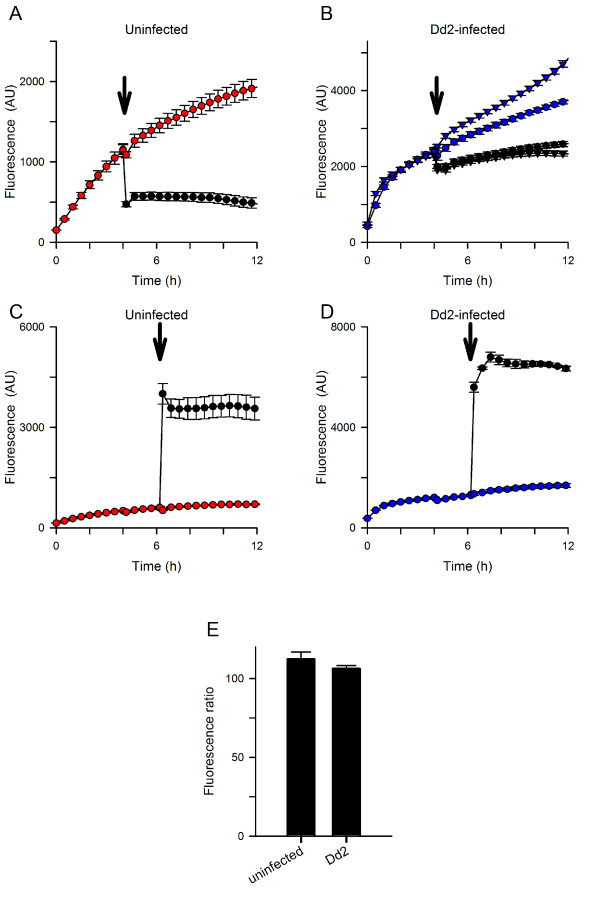
Effects of EGTA and SDS. (A, B) Addition of EGTA to chelate extracellular Ca++ 4 hours after initiating uptake (arrow in each panel; final [EGTA], 3.33 mM); the free Ca++ was buffered at 1.0 mM prior to EGTA addition. Panel A shows uninfected cells in the absence of probenecid. Here, EGTA addition abruptly reduces the fluorescence and prevents further increases (black circles); control kinetics are shown for resuspension of cells without addition of chelator (red circles). Panel B shows matched experiments for Dd2-infected cells in both the presence and absence of 5 mM probenecid (triangles and circles, respectively). With infected cells, the initial reduction with EGTA addition is smaller (black symbols), suggesting a lesser contribution of exported Fluo-8. EGTA prevents subsequent increases in fluorescence; probenecid-induced augmentation is also abolished (compare black triangles to black circles). These processes depend on extracellular Ca++ and uptake at the host membrane. (C, D) Addition of SDS to lyse cells 6 hours after initiating uptake with uninfected and Dd2-infected cells in the absence of probenecid (arrows; final [SDS], 0.05%). Note the large increases in fluorescence after addition of SDS (black circles), when compared to resuspension only kinetics (red or blue circles). (E) Effect of probenecid on plateau fluorescence after SDS addition, calculated by normalization of matched controls without probenecid to 100%. Bars represent mean ± S.E.M. of replicates from 2-3 independent experiments.